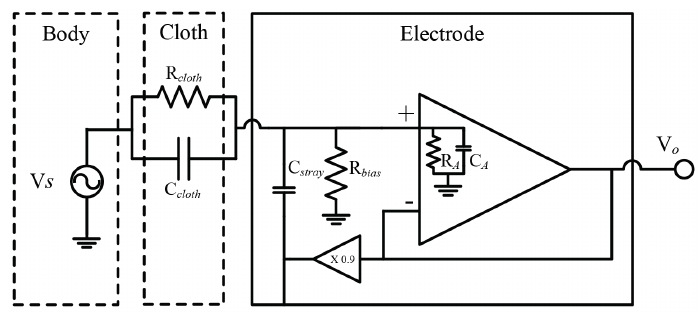
Figure 3. Overall equivalent circuit of the